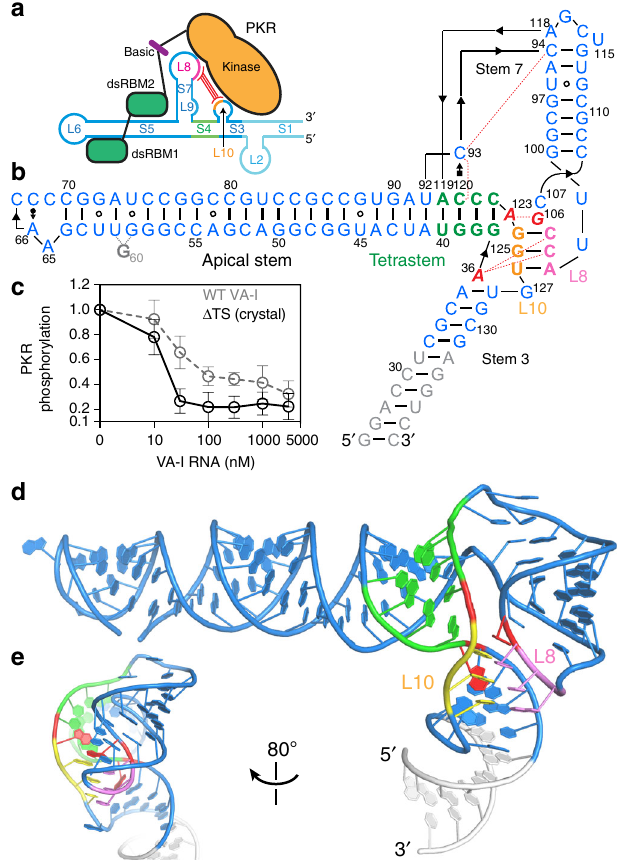
Fig. 1 Overall structure of Adenovirus 2 VA-I RNA. a Cartoon model of VA-I and PKR interactions. S: stem; L: loop. S1 and L2 were absent from the crystal construct. b Secondary structure of crystallized VA-I RNA. Tetrastem: green, Loop 8: violet, Loop 10: orange, engineered sequences: gray. Three single-stranded, helix-capping purines, A36, G106, and A123, are in red italics. Leontis – Westhof symbols 74 denote non-canonical base pairs. Arrowheads denote chain connectivity. Dotted red lines indicate hydrogen bonds. G60 is disordered. c Inhibitory activities of wild-type and Δ TS (deletion of terminal stem; crystallization construct) VA-I. Several Δ TS RNAs showed an enhanced inhibitory activity than WT, as previously reported 26 . Error bars here and thereafter represent standard deviations (s.d.) from three independent replicates. d , e Two views of the